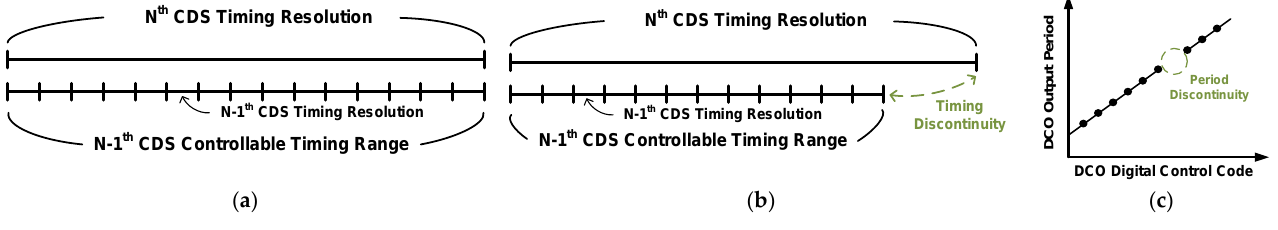
Figure 4. ( a ) Total controllable timing range of a single stage is equal to the timing resolution of the previous controllable delay stage (CDS); ( b ) Total controllable timing range of a single CDS is less than the timing resolution of the previous CDS; ( c ) A large period difference occurs when the control code sweeps across different CDSs.